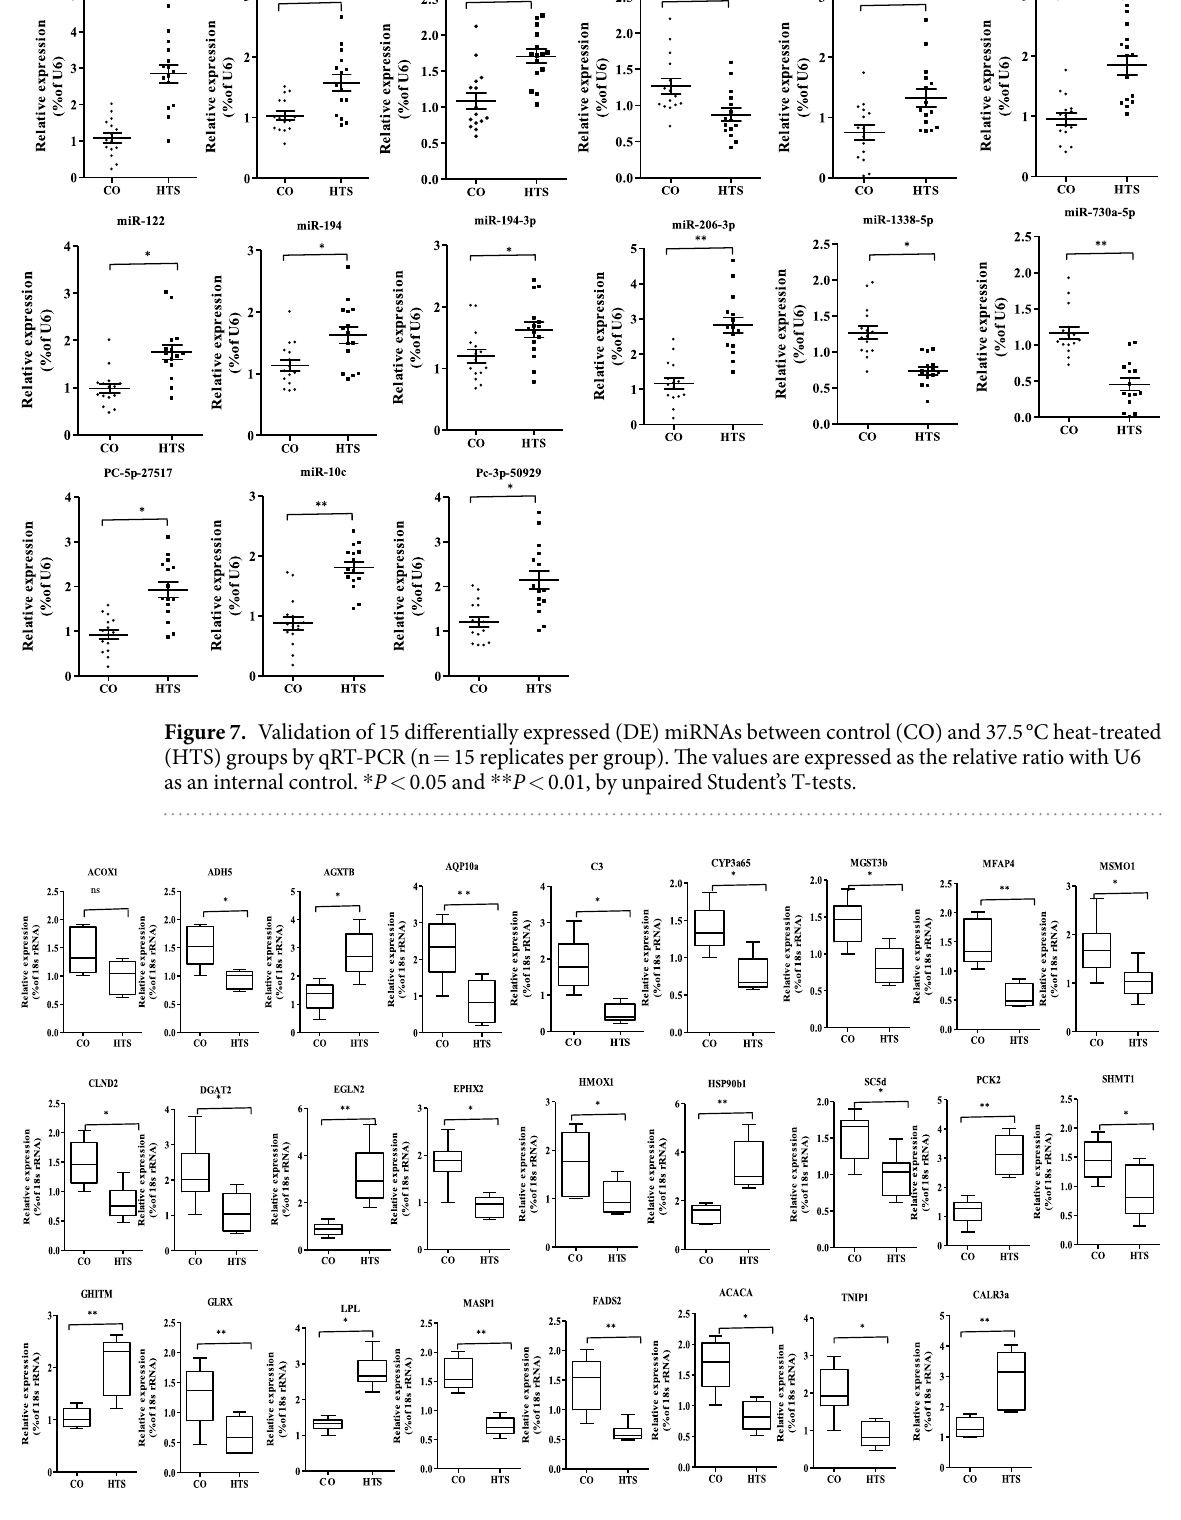
Figure 8. Validation of 26 differentially expressed (DE) mRNAs between control (CO) and 37.5 °C heat-treated (HTS) groups by qRT-PCR (n = 15 replicates per group). The expression levels of mRNA were normalized to that of 18 s rRNA as an internal control. * P < 0.05 and ** P < 0.01, NS, no significant difference, by unpaired Student’s